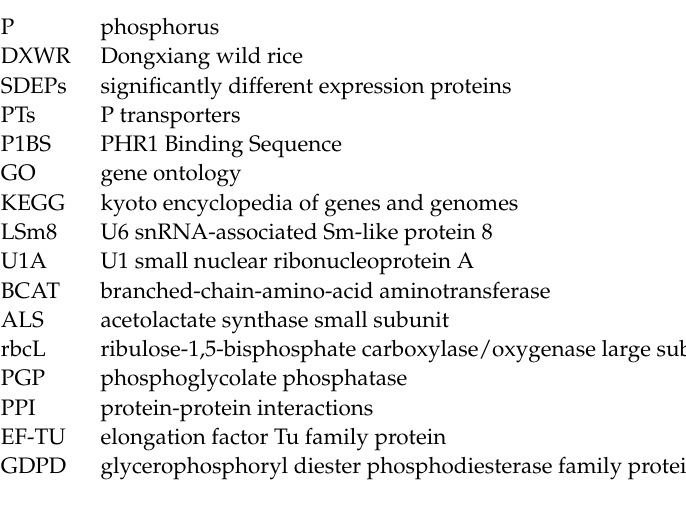
Figure S1: Molecular weight distribution. Supplementary Table S2: List of proteins identified from RLP and RCK samples with three biological repetitions, respectively. Supplementary Table S3: List of peptides identified from RLP and RCK samples with three biological repetitions, respectively. Supple- mentary Table S4: List of GO function enrichment analysis of proteins identified from RLP and RCK. Supplementary Table S5: List of KEGG pathway mapping of proteins identified from RLP and